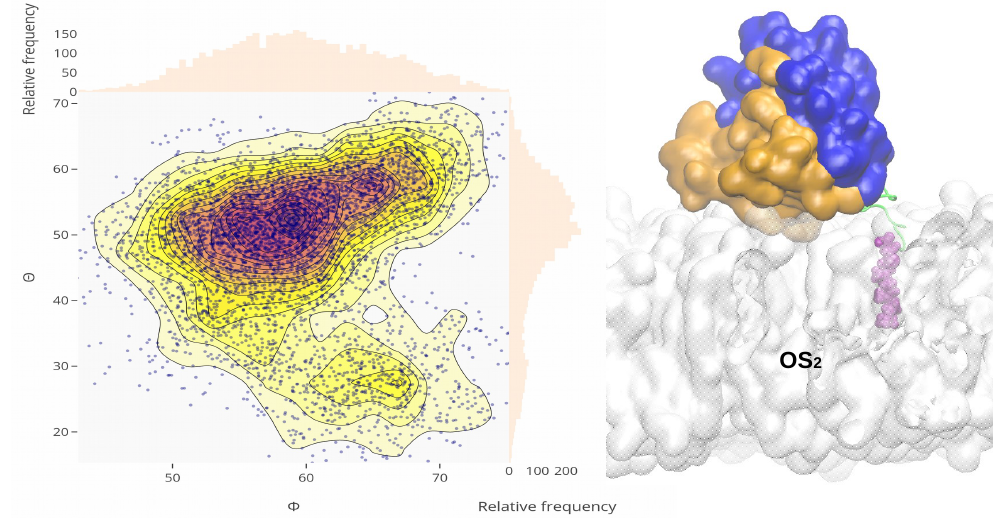
Figure A4. Orientation of the wild-type KRas-4B-Far on the chol.-0% membrane. Colors defined as Figure 5.